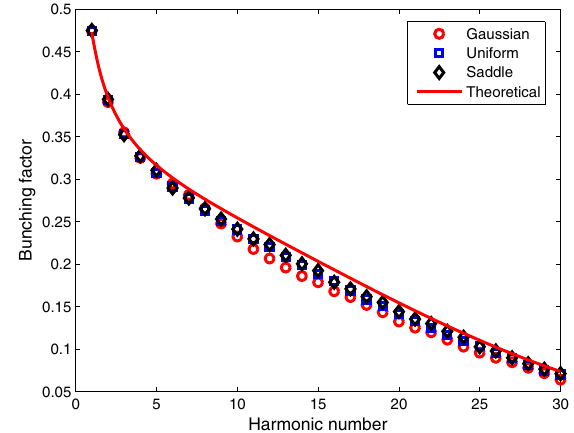
FIG. 4. The evolution of PEHG bunching factor vs the harmonic number, the dots are the simulation results, and the red line is theoretical derivation of the PEHG bunching factor with an effective energy spread.